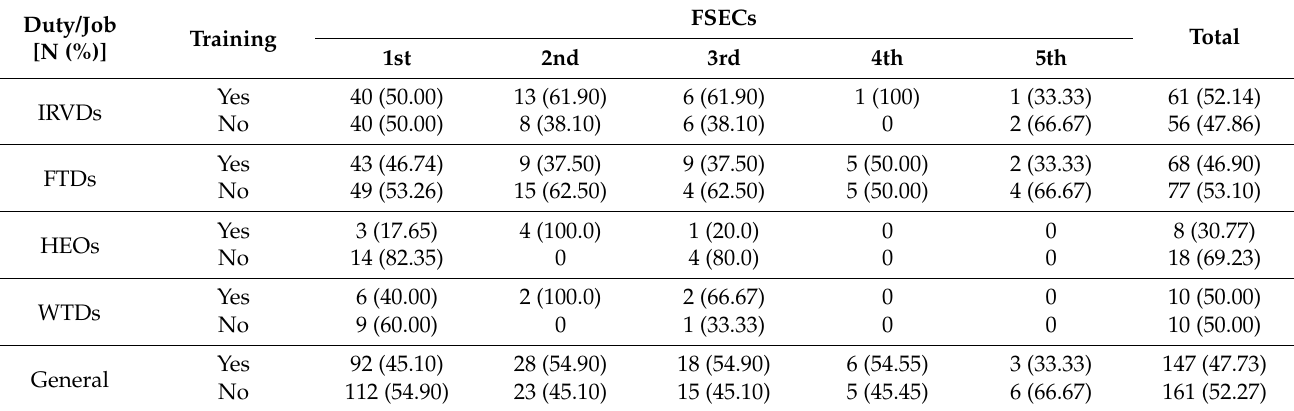
Table 6. Advanced driving technique training for FFFs and their participation status.